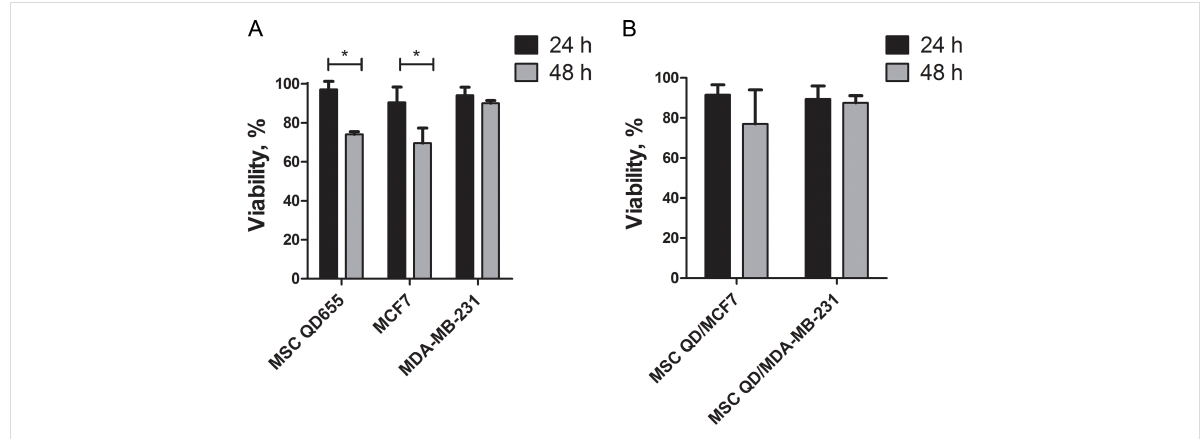
Figure 5: The viability of mesenchymal stem cells (MSCs), MCF7 and MDA-MB-231 cells in spheroids. The viability of cells was analysed in 3D monocultures (A) and 3D co-cultures (B) after 24 h and 48 h of cultivation on polyHEMA coatings. * p -value < 0.05.